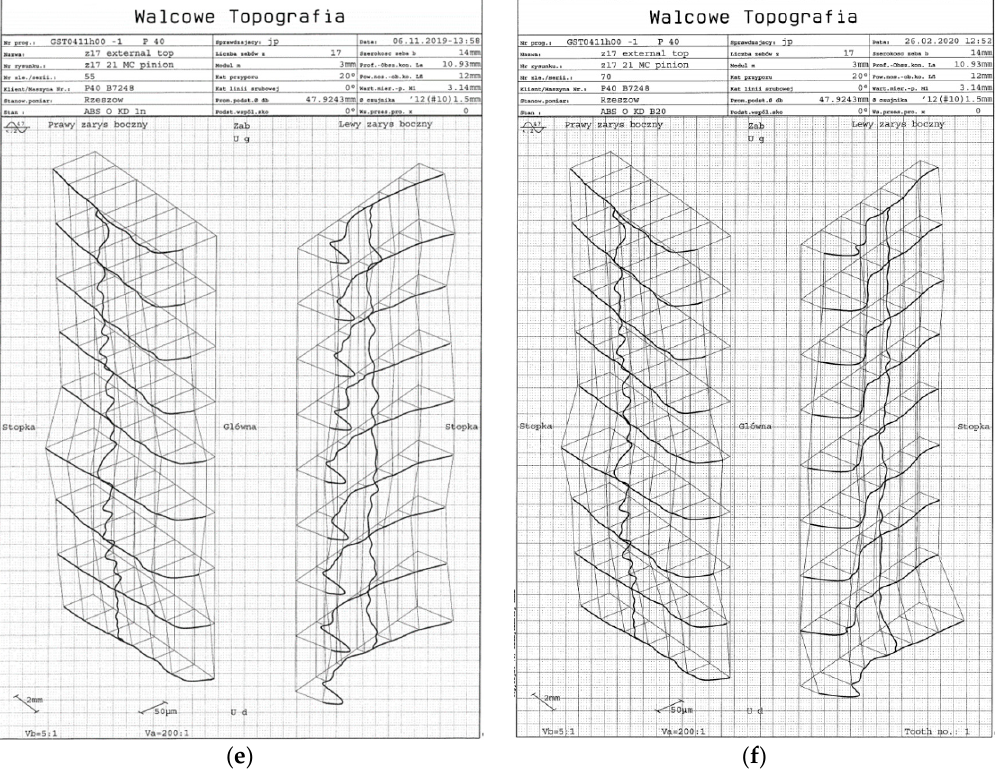
Figure 8. Results of topography measurement for pinion z17 before and after tests for selected representative samples ( a ) PEEK pre-test; ( b ) PEEK post-test; ( c ) ULTEM 9085 pre-test; ( d ) ULTEM 9085 post-test; ( e ) ABS M-30 pre-test; ( f ) ABS M-30 post-test.